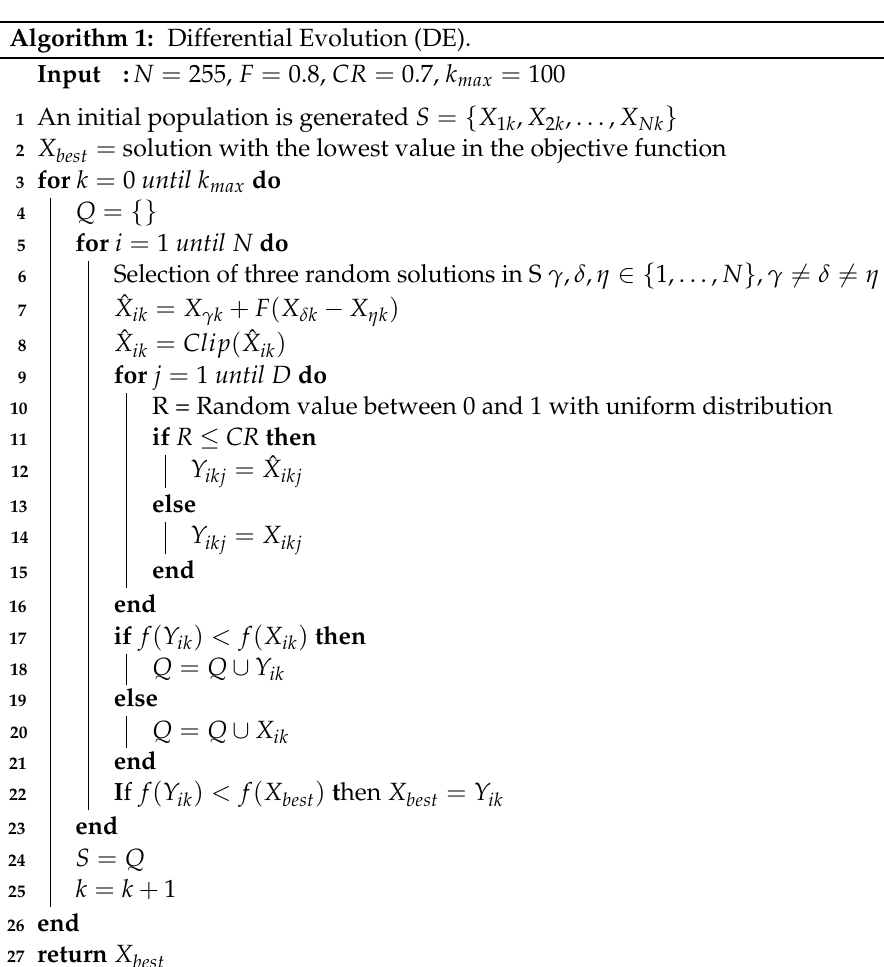
Algorithm 1: Differential Evolution